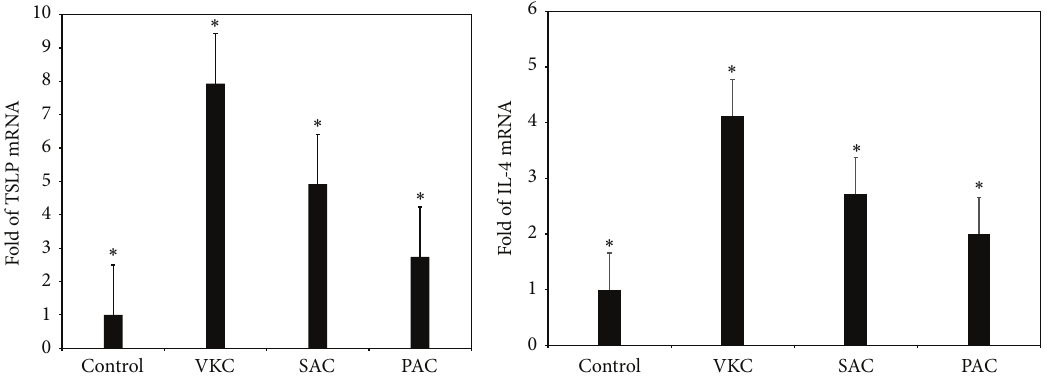
(b) Relative expression levels of IL-4 mRNA in different types of allergic conjunctivitis